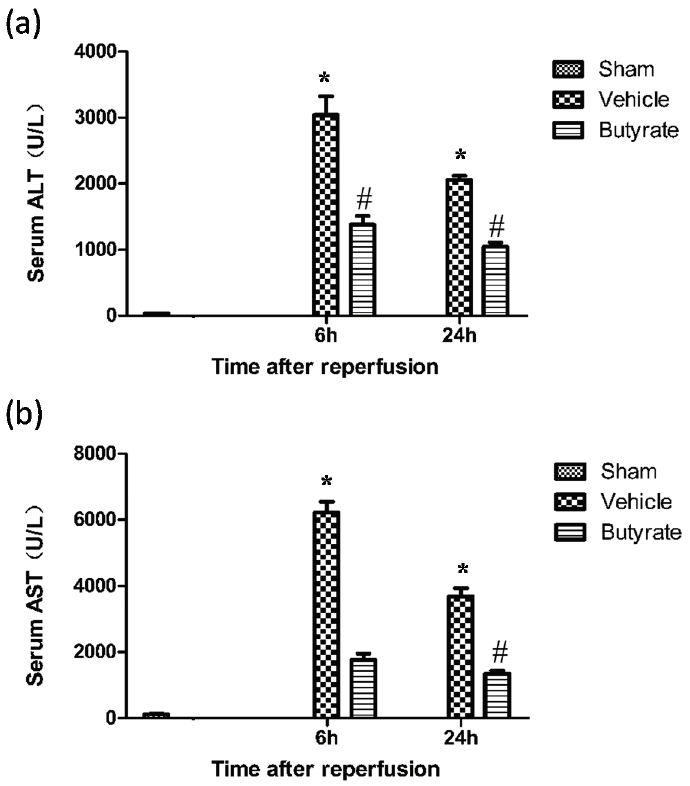
Figure 1. Serum alanine aminotransferase (ALT) ( a ) and aspartate aminotransferase (AST) ( b ) levels at 6 and 24 h after reperfusion. The levels of ALT and AST significantly increased in the vehicle group, which was markedly reduced by butyrate administration. Data represent means ± standard deviation (SD), n = 4–5 rats per group. * p < 0.05 vs. the sham group, # p < 0.05 vs. the vehicle